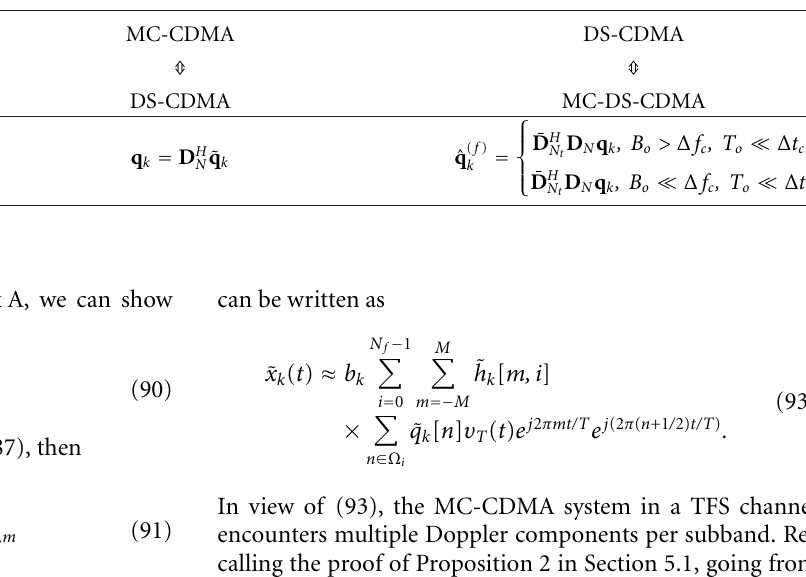
Table 4: Summary of equivalence results for a TFS channel—Part 1. T o and B o refer to the duration and bandwidth of MC-DS-CDMA basis